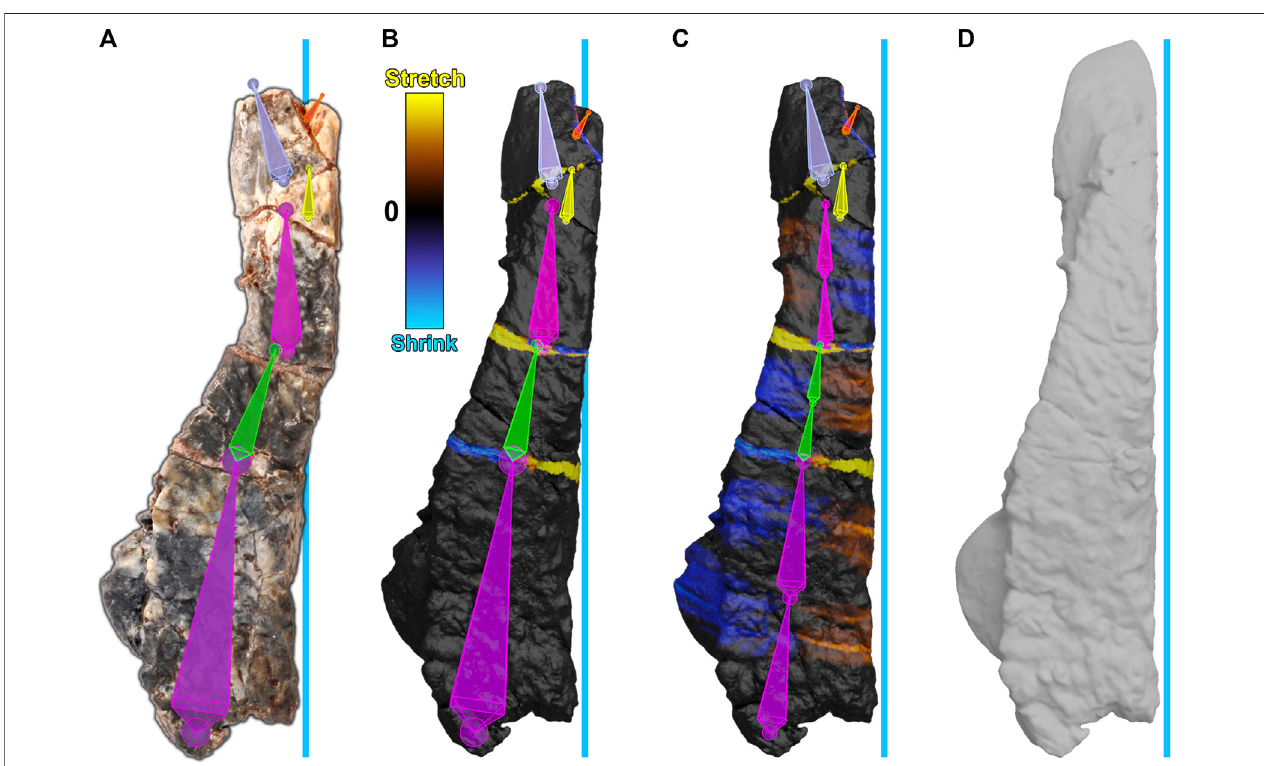
FIGURE 7 | Digital restoration of the frontal bone. The blue line represents the midline of the skull. (A) The frontal bone as preserved with armature superimposed. Segments are arbitrarily colored for visibility. (B) The frontal bone after brittle retrodeformation and (C) after subsequent plastic retrodeformation with cumulative 2-color tension maps documenting local mesh distortions. Each of the lower three segments (purple, green, pink) have been subdivided into two subsegments. The second subsegment of each division is used for plastic retrodeformation while the fi rst subsegment retains its usage for brittle retrodeformation. (D) The restored frontal